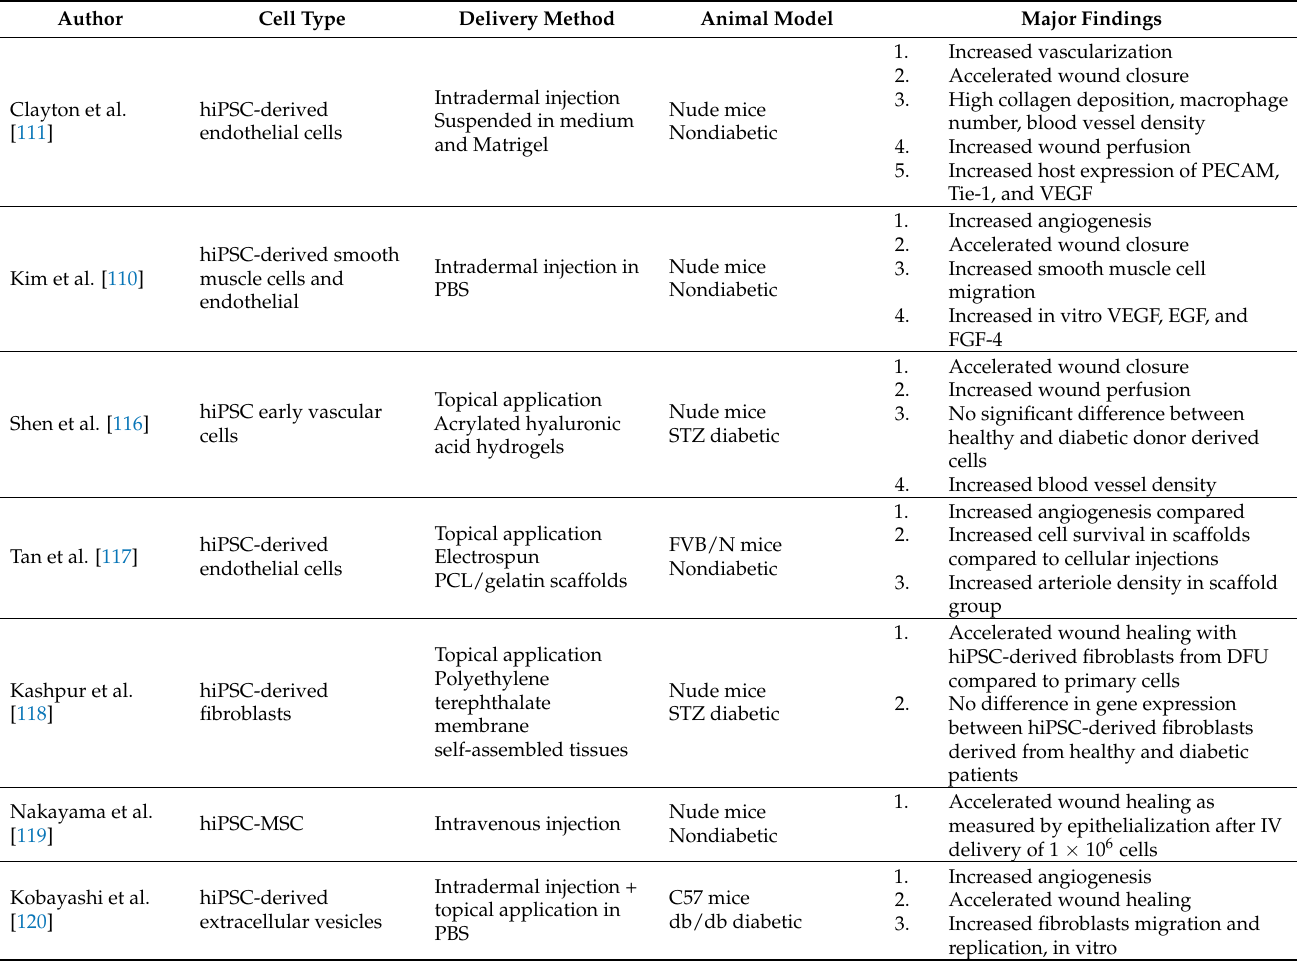
Table 1. Summary of studies implying induced pluripotent stem cells in cutaneous wound healing in a murine model, including cell type, delivery method, animal model, and major findings